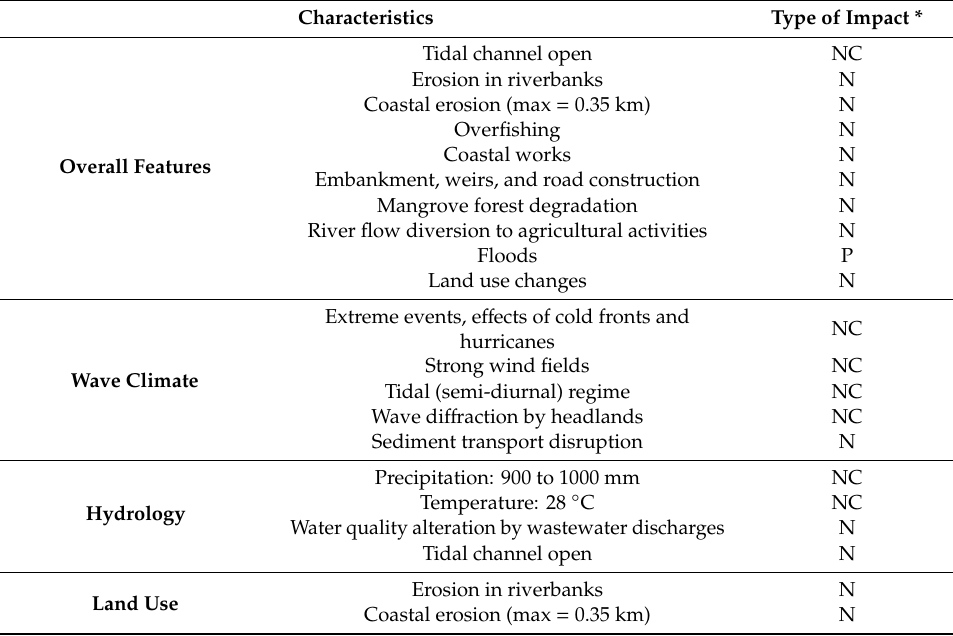
Table 2. Status of